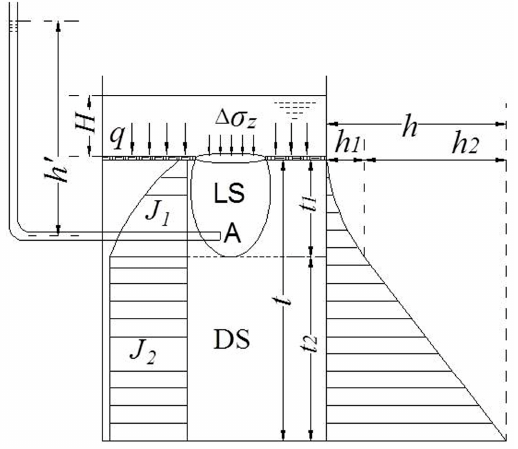
Figure 4. Schematic illustration of the piezometric head and critical